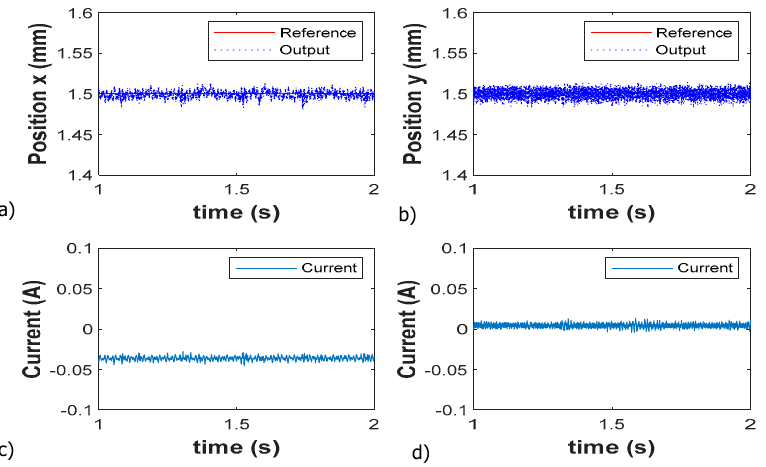
Figure 14. The response of control current during reference command tracking of AMB system in both x and y planes.